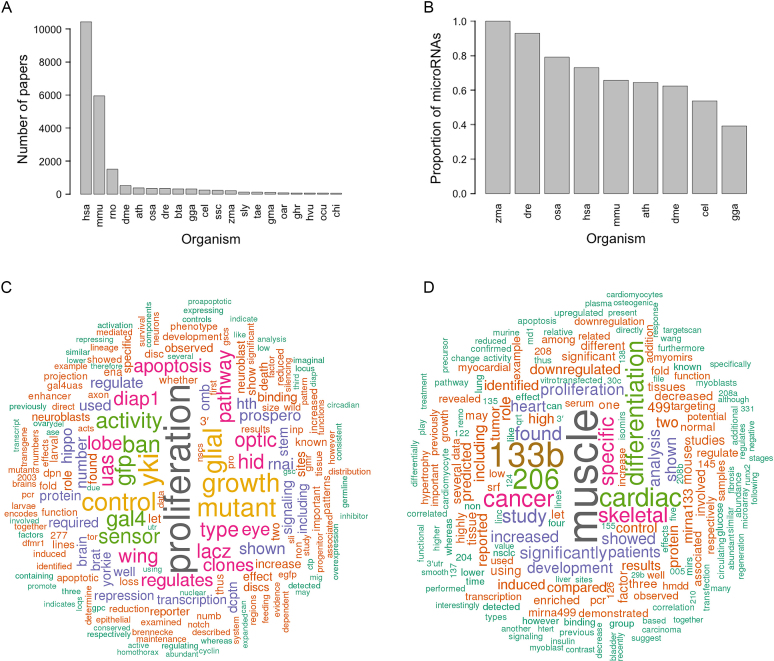
MicroRNA functional information mined from open access papers. (A) The top 20 species according to the number of open access papers associated with their microRNAs. (B) The proportion of microRNAs from selected model organisms that have papers and sentences associated. (C) Word cloud for Drosophila melanogaster bantam microRNA. (D) Word cloud for hsa-mir-133a-2. Species abbreviations: hsa: Homo sapiens, mmu: Mus musculus, rno: Rattus norvegicus; dme: Drosophila melanogaster; ath: Arabidopsis thaliana; osa: Oryza sativa; dre: Danio rerio; bta: Bos taurus; gga: Gallus gallus; cel: Caenorhabditis elegans; ssc: Sus scrofa; zma: Zea mays; sly: Solanum lycopersicum; tae: Triticum aestivum; gma: Glycine max; oar: Ovis aries; ghr: Gossypium hirsutum; hvu: Hordeum vulgare; ocu: Oryctolagus cuniculus; chi: Capra hircus.